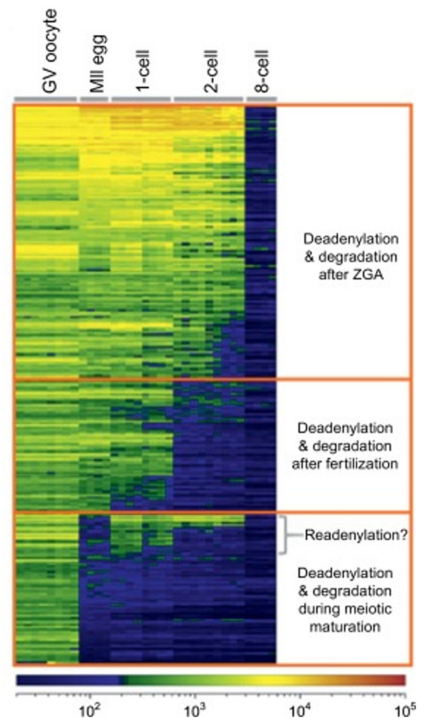
Figure 9. Microarray profiling of ~300 oocyte-specific genes during maturation. The color scale indicates mRNA abundance according to fluorescence intensity (arbitrary units). ZGA: Zygotic genome activation. Source: Svoboda et al., 2015